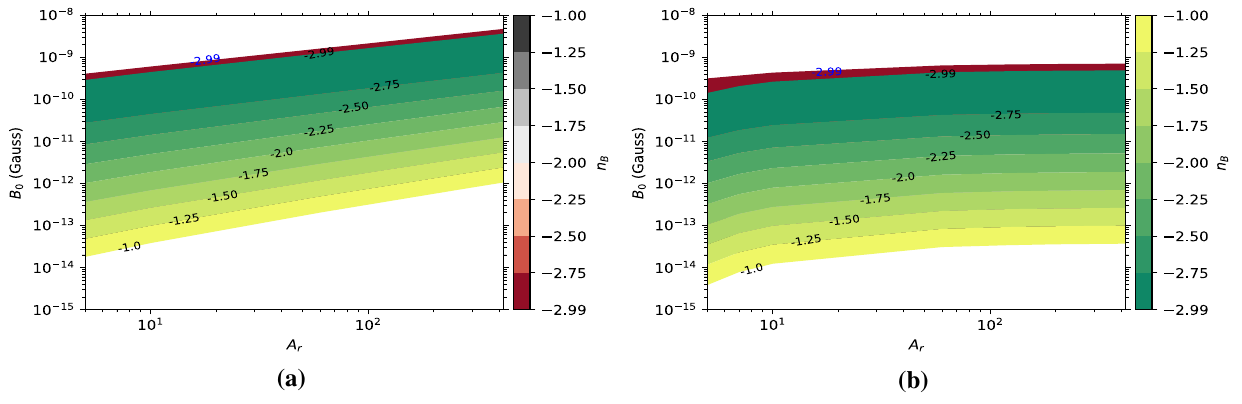
Fig. 3 In these plots, we study upper bounds on present-day mag- with black coloured text. In plot a , we consider T S (cid:10) T gas and do not netic field strength ( B 0 ) with excess radiation fraction ( A r ) for differ- take into account the X-ray and VDKZ18 effects. While in figure b , we consider the effects of VDKZ18 and X-ray on IGM gas due to first ent values of the spectral index, n B . The green-yellow and red-grey stars after z (cid:2) 35 and consider finite Ly α coupling. The colour-bars are colour schemes represent the cases when T 21 | z = 17 . 2 (cid:10) − 500 mK and − 300 mK, respectively. For T | (cid:10) − 300 mK case the value of common for both z = 17 . 2 21 n B writtenwithbluecolouredtext,whilefor − 500 mKcaseitiswritten